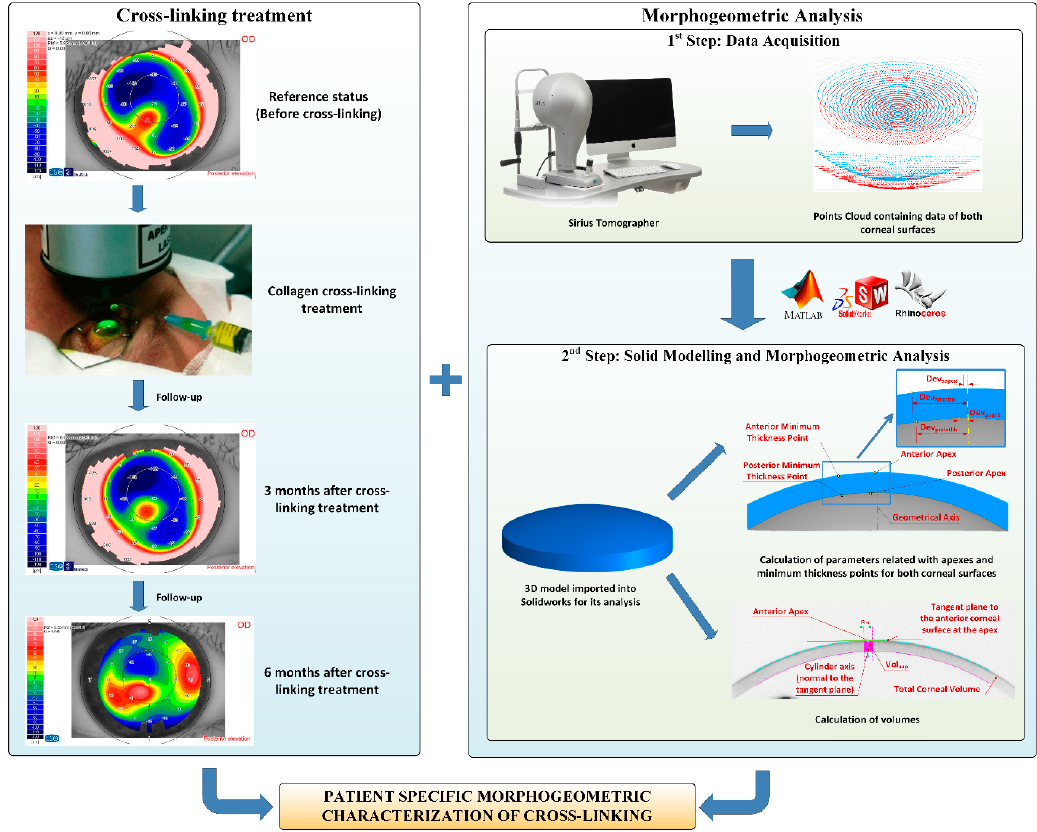
Figure 1. Sequence in the cross-linking treatment, and its follow-up (left) and procedure for the 3D corneal model generation and later analysis (right). The data obtained from the Sirius tomographer permitted the generation of a customized 3D model, in which several morphogeometric variables were studied.